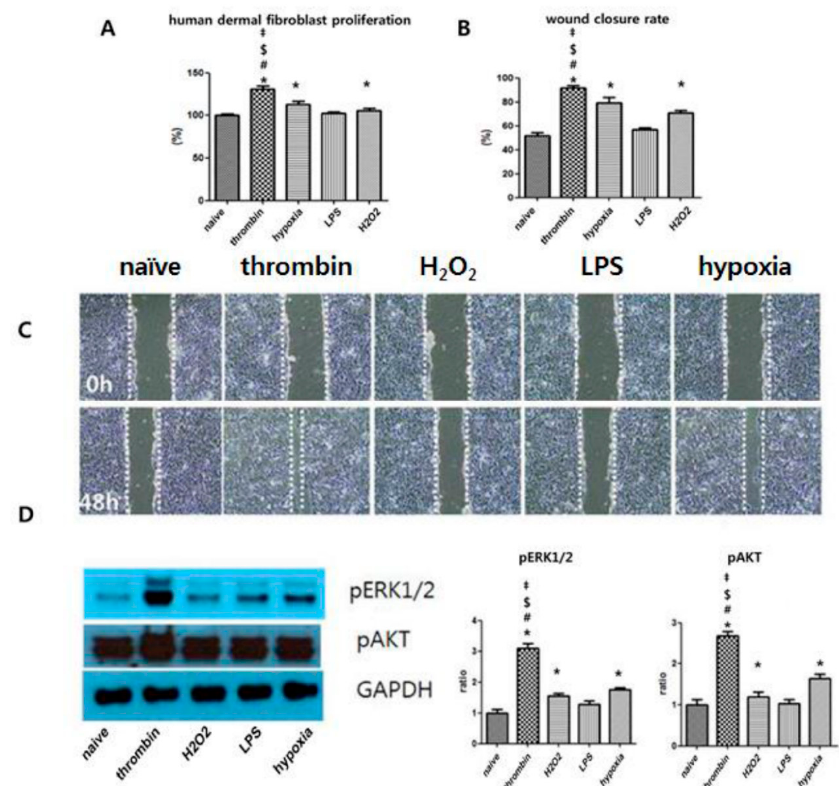
Figure 6. The promotion of proliferation of human dermal fibroblasts with stimulation of EVs. ( A ) Proliferation rates of human fibroblasts following treatment with normal and thrombin-, 10% O 2 -, LPS-, H 2 O 2 -treated EVs for 24 h. Wound closure rate was detected by wound scratch assays as described in Materials and Methods. ( B ) Rates of wound closure were quantified using Image J. ( C ) Representative images of wound scratch assays at the treatment of the normal control and with thrombin, H 2 O 2 , LPS, and hypoxia. ( D ) Lysate from human dermal fibroblast cells treated with EVs for 24 h subjected to Western blot analysis. Cell lysate was analyzed by immunoblotting and normalized to GAPDH, and the ratio of densitometry to GAPDH is shown beneath the blots. Data are presented as mean ± SEM. Statistical analyses were carried out using a One-way Analysis of Variance (ANOVA). The asterisk(*) indicates p < 0.05 compared with naive EVs, the number sign(#) indicates p < 0.05 compared with the 10% oxygen-treated EV group, the double dagger(‡) indicates p < 0.05 compared to the H 2 O 2 -treated EV group, and the dollar sign($) indicates p < 0.05 compared with the LPS-treated EV group ( n = 5 per each analysis).